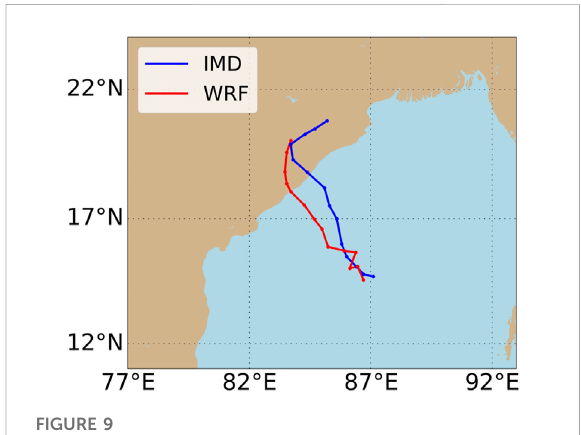
FIGURE 9 Observed (IMD best-track) and simulated (WRF) tracks of TC Titli (2018) over the NIO initialized at 00 UTC 2018 – 10-09 using the input forcings from the NCEP 1 o × 1 o fi nal analysis